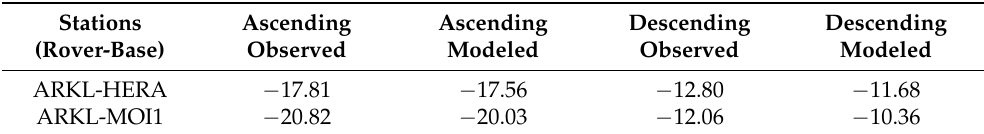
Table 4. Observed and modelled co-seismic offset (cm) of GNSS processing projected on LOS